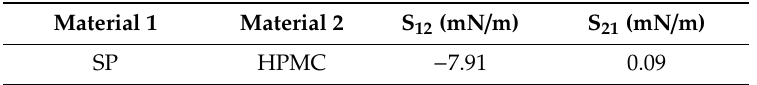
Table 3. Spreading coe ffi cient of SP over HPMC (S 12 ) and of HPMC over SP (S 21